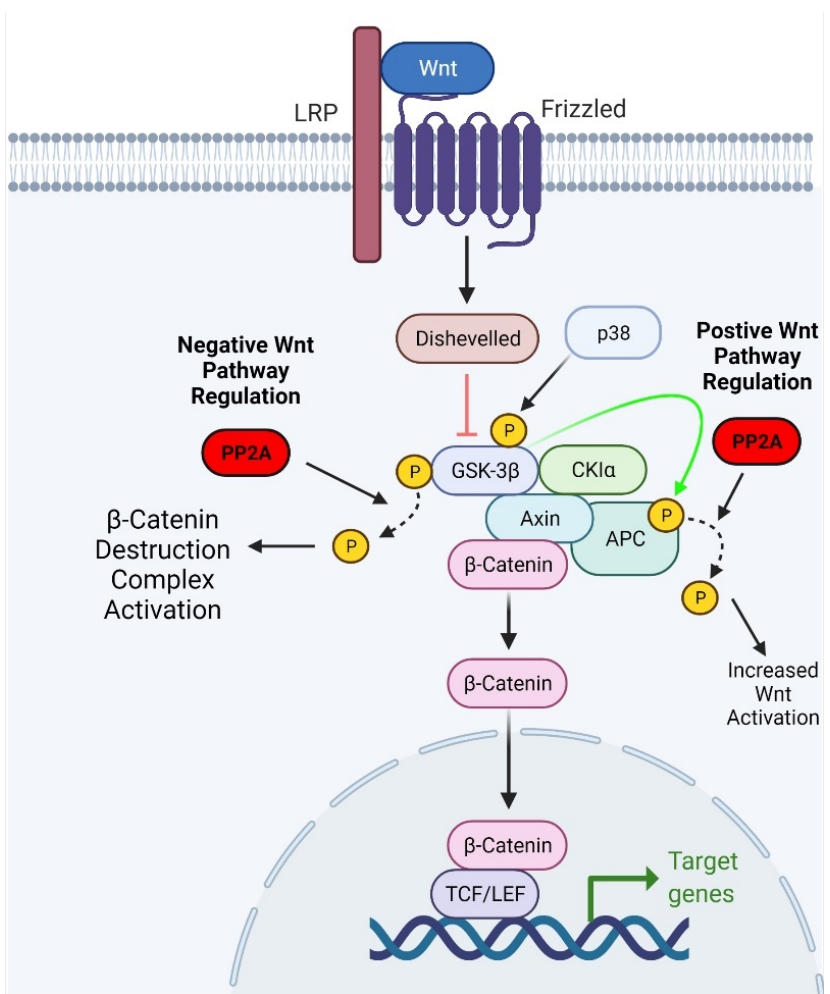
Figure 2. Schematic representation of the effect of PP2A on Wnt signaling. PP2A can reverse p38- dependent phosphorylation of GSK3 β , thus activating its kinase activity. Activation of GSK3 β leads to the ubiquitination and degradation of β -Catenin. Adapted from “Wnt Beta-Catenin Signaling Path- way,” by BioRender.com (2021). Retrieved from https://app.biorender.com/biorender-templates, accessed on 11 May